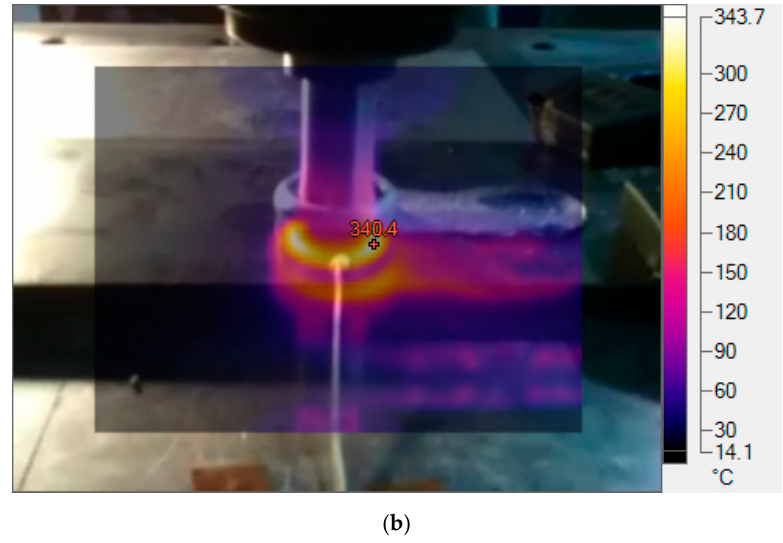
Figure 8. Infrared thermal images: ( a ) V = 60 mm/min; ( b ) V = 100 mm/min.